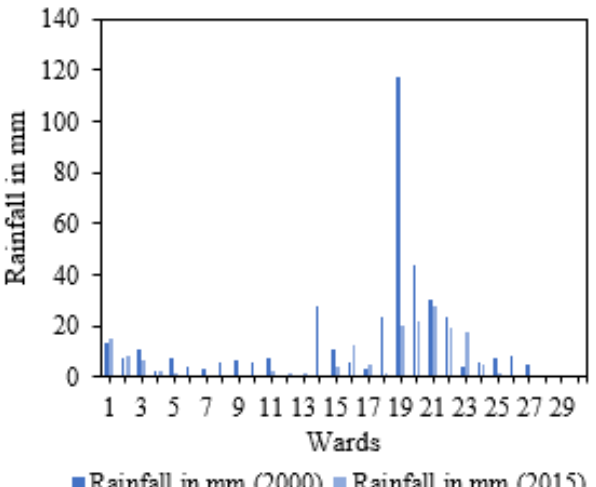
Figure 7. Daily rainfall situation (September 2000 and 2015).